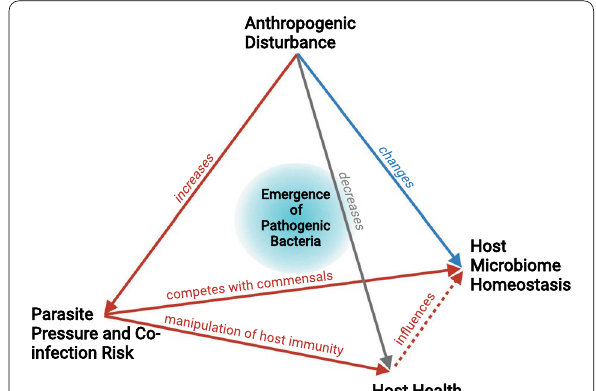
Fig. 4 Pathways to novel, potentially pathogenic bacterial disease agents. Aside from direct changes to the host microbiome caused by habitat disturbances (blue arrows), parasites directly impact host microbiome (red solid arrow) and indirectly via manipulation of host health (red dashed arrow). Since anthropogenically disturbed habitats facilitate the transmission and persistence of parasites, direct and indirect parasite-mediated changes to a host’s microbiome may become more frequent, and a dysbiotic gut may become a source of harmful bacteria. Adapted from